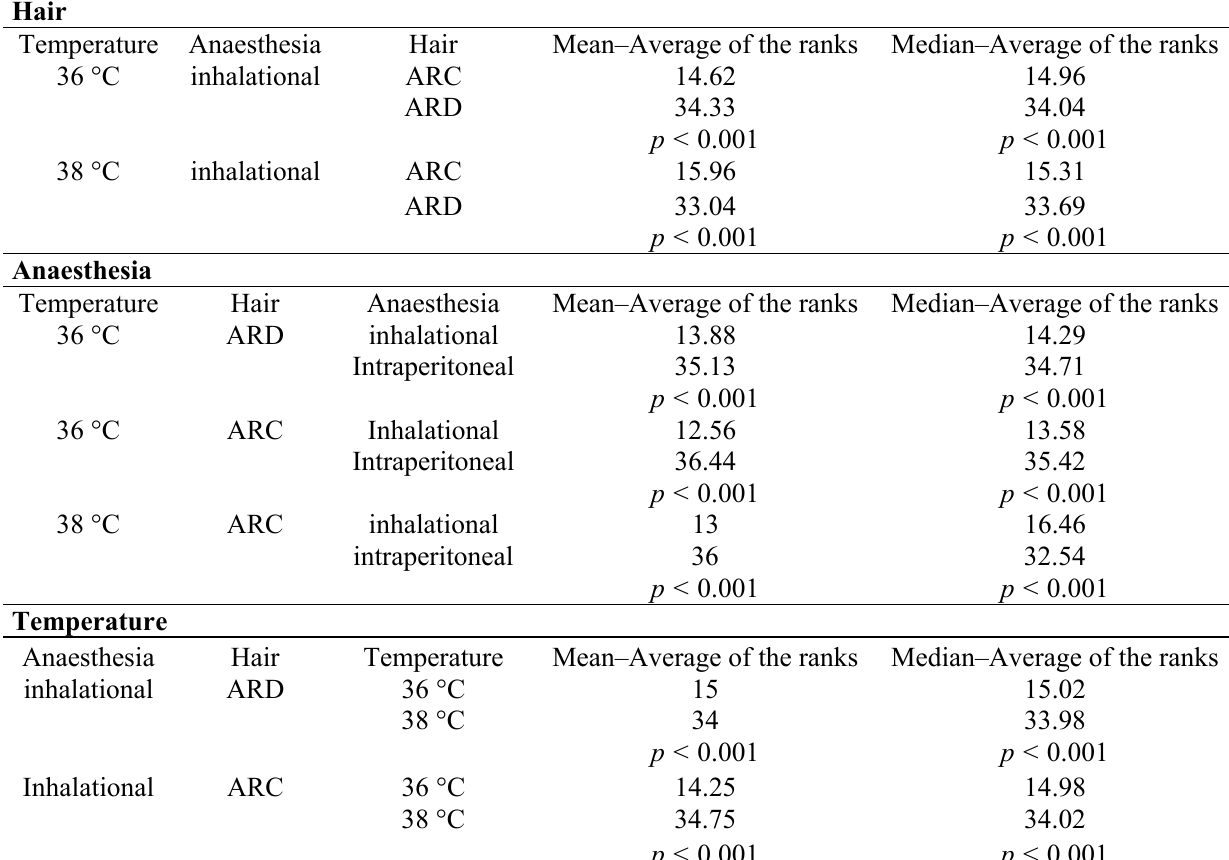
Table 3. Inferential Statistics. The results of a Mann-Whitney test for the effects of hair, anaesthesia and temperature when the mouse is placed in the dorsal decubitus